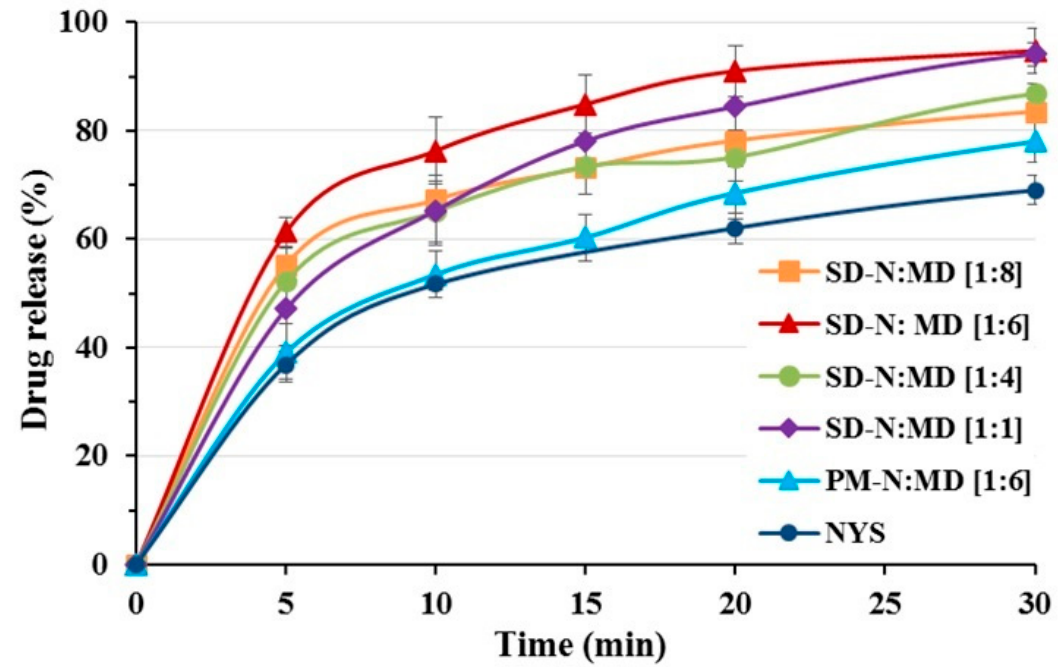
Figure 5. Dissolution profiles of nystatin raw material (NYS), PM-N:MD [1:6] physical mixture, and SD-N:MD [1:1],